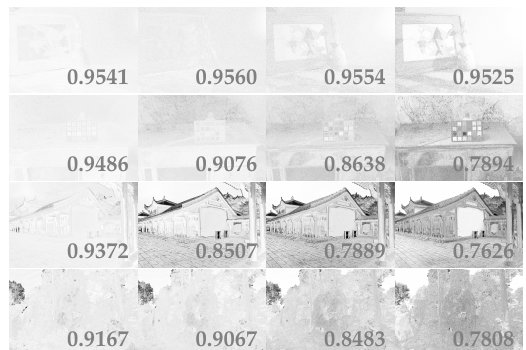
Figure 2. The SSIM (Structural Similarity) index maps of virtual images of different exposure times. The exposure ratios are 2, 4, 8, and 16 from right to left. The SSIMs are in the lower left corner of the images.